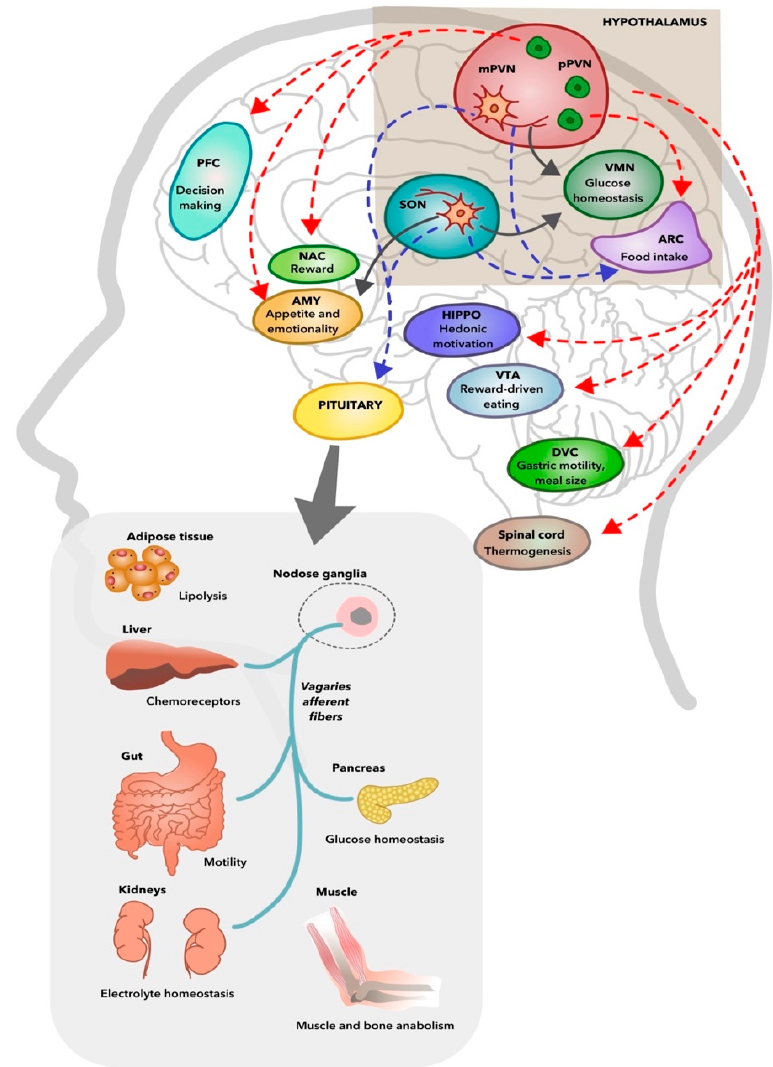
Figure 1. The central and peripheral targets of the brain oxytocin systems in metabolic regulation. Oxytocin is synthesized from the magnocellular neurons of both the paraventricular nucleus (PVN) and supraoptic nucleus (SON). The PVN and SON are sensitive to nutrients (e.g., glucose, sucrose, and leucine) and other hormones (e.g., leptin, insulin, cholecystokinin, and glucagon-like peptide type 1) and influence energy intake and energy balance. Magnocellular oxytocin neurons in the PVN (mPVN) and SON possess axonal projections to the neurohypophysis of the pituitary, from which oxytocin is released into systemic circulation. Parvocellular oxytocin neurons in the PVN (pPVN) project axons to a variety of brain regions, including to the arcuate nucleus (ARC) (receives afferent oxytocin fibers from both mPVN and pPVN), the ventral tegmental area (VTA), the nucleus accumbens (NAc), the amygdala (AMY), the hippocampus (HIPPO), prefrontal cortex (PFC), dorsal vagal complex (DVC), and spinal cord, each of which contains oxytocin receptor-expressing neurons and has important involvement in the regulation of energy balance. Moreover, extrasynaptic oxytocin release from the dendrites of magnocellular oxytocin neurons in the PVN and SON into the ventromedial nucleus (VMN) and AMY are also seen. Oxytocin exerts metabolic effects in multiple organ systems (e.g., gastrointestinal motility, muscle and bone anabolism, lipolysis, and pancreatic insulin secretion) through the secretion of oxytocin in the periphery via the neurohypophysis of the